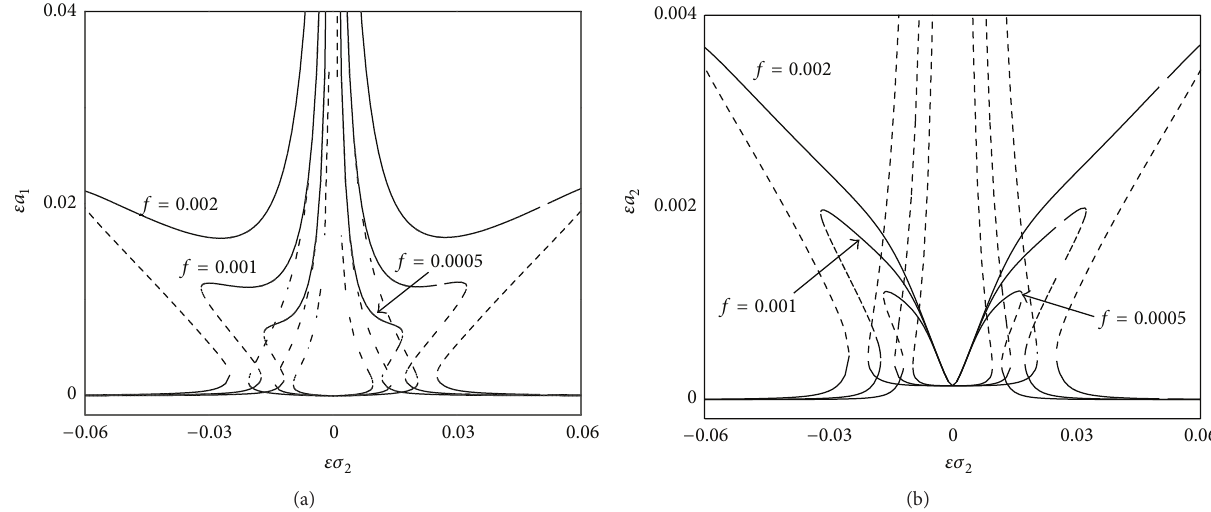
Figure 15: Amplitude-frequency curves of the difference resonance for different external excitation amplitudes: (a) the first mode and (b) the second